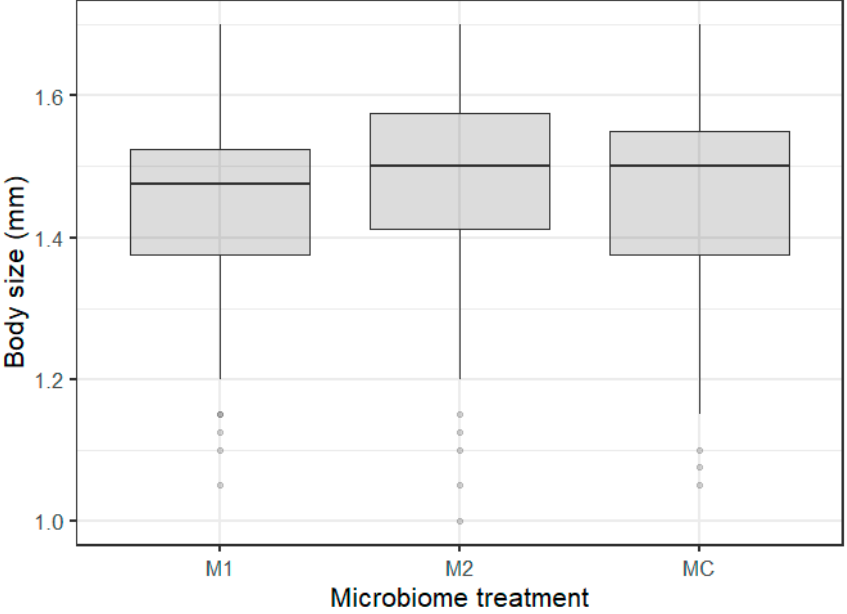
Figure 3. Boxplots of Daphnia body size exposed to the different microbiome treatments (M1, M2, and MC).